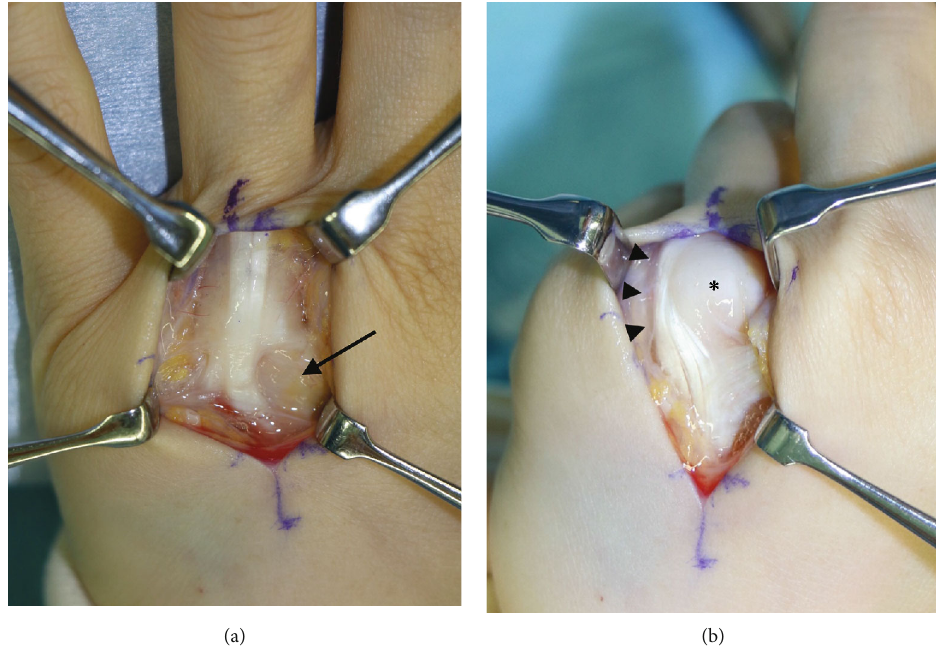
Figure 2: Surgical image for the extensor tendon of the ring fi nger of the left hand. (a) Attenuated radial sagittal band (black arrow). (b) The metacarpal head of the ring fi nger pops through the attenuated sagittal band (asterisk) with the extensor tendon dislocated ulnarly (black arrowheads) in the shiatsu-speci fi c hand